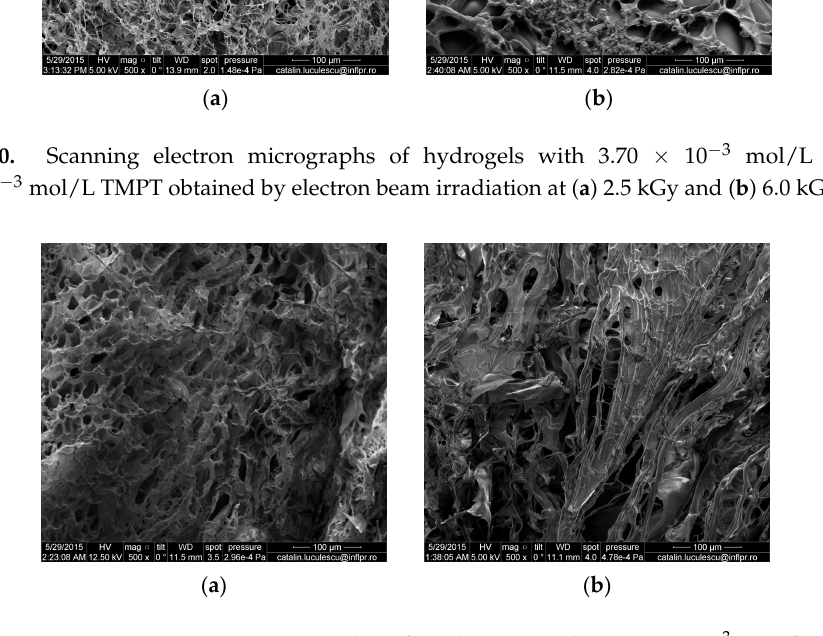
Figure 11. Scanning electron micrographs of hydrogels with 7.40 × 10 − 3 mol/L PP and 5.90 × 10 − 3 mol/L TMPT obtained by electron beam irradiation at ( a ) 2.5 kGy and ( b ) 6.0 The cross-link density and composition affect the microstructure of hydrogels, which influences